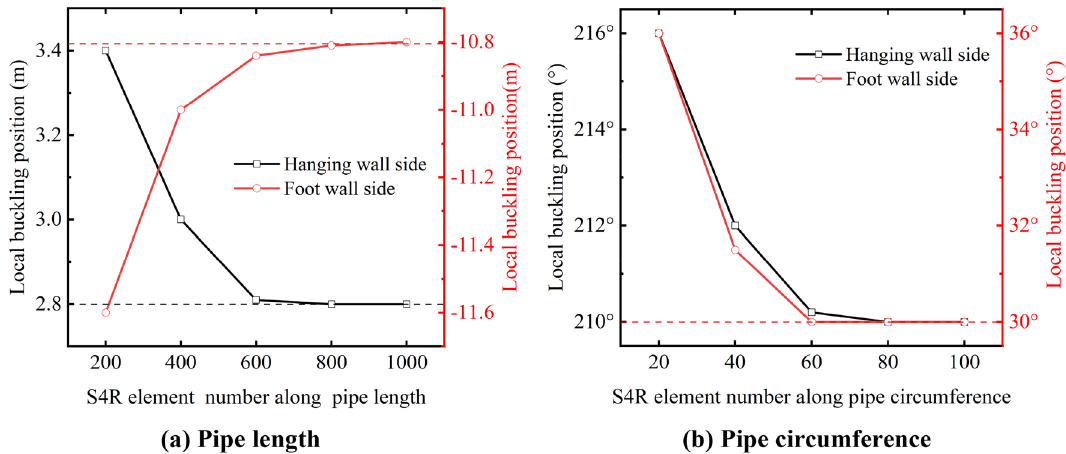
Figure 6. Influence of mesh density on pipe local buckling position.